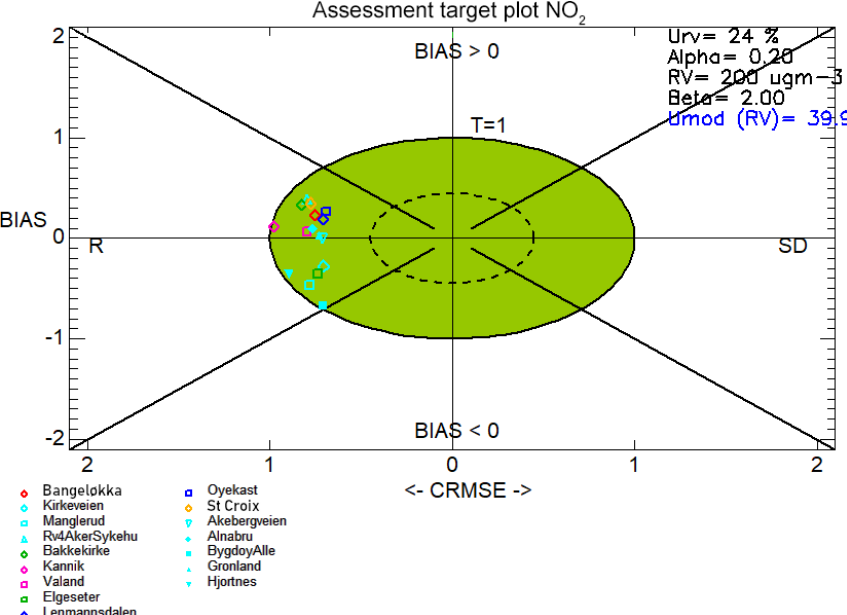
Figure 11. Target plots created with hourly time series of NO 2 concentrations for 2015 for all 16 in situ stations used for the model evaluation across all six domains. The symbols are colour-coded according to each model domain: Drammen is red, Oslo is cyan, Trondheim is green, Stavanger is pink, Grenland is dark blue, and Nedre Glomma is